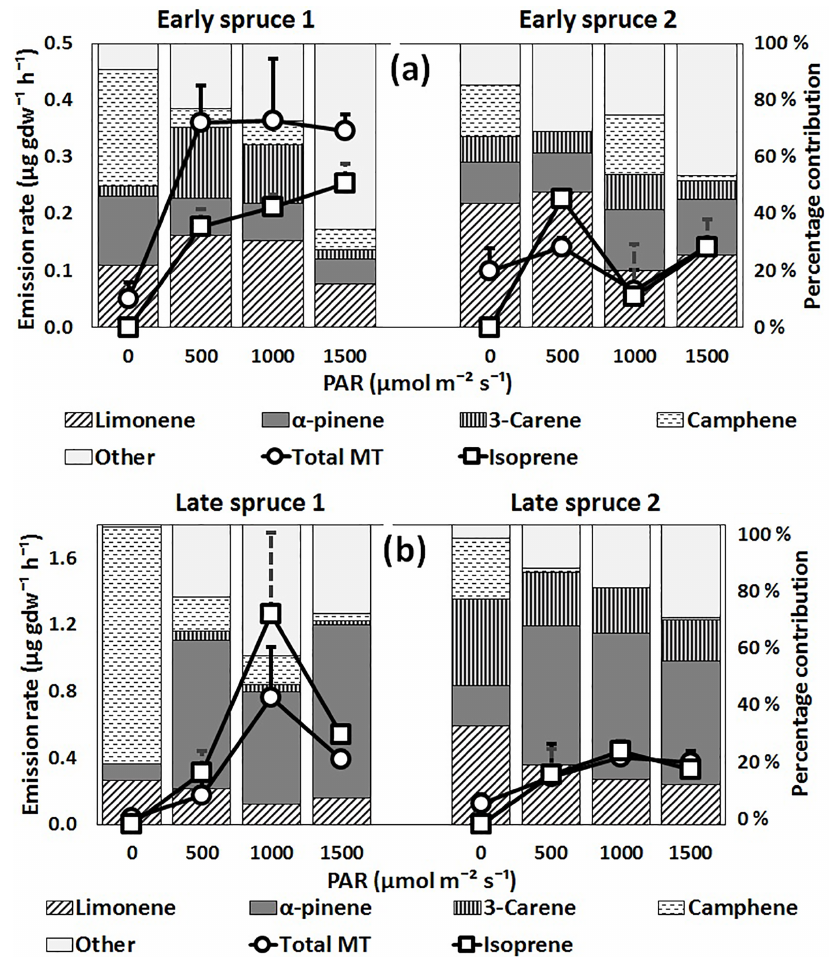
Figure 3. The total BVOC emission rate from two individuals of Norway spruce with (a) an early budburst and (b) a late budburst and the relative contribution of the major compounds at four intensities of photosynthetically active radiation (PAR). The open circles show total monoterpene emission, whilst the open squares show isoprene emission of all measured twigs ( n = 3–6 twigs). The error bars are the SD of the data. The category “Other” contains the compounds tricyclene, β -pinene, eucalyptol and linalool for early spruce and tricyclene, β -pinene, α -terpinene eucalyptol and γ -terpinene for late